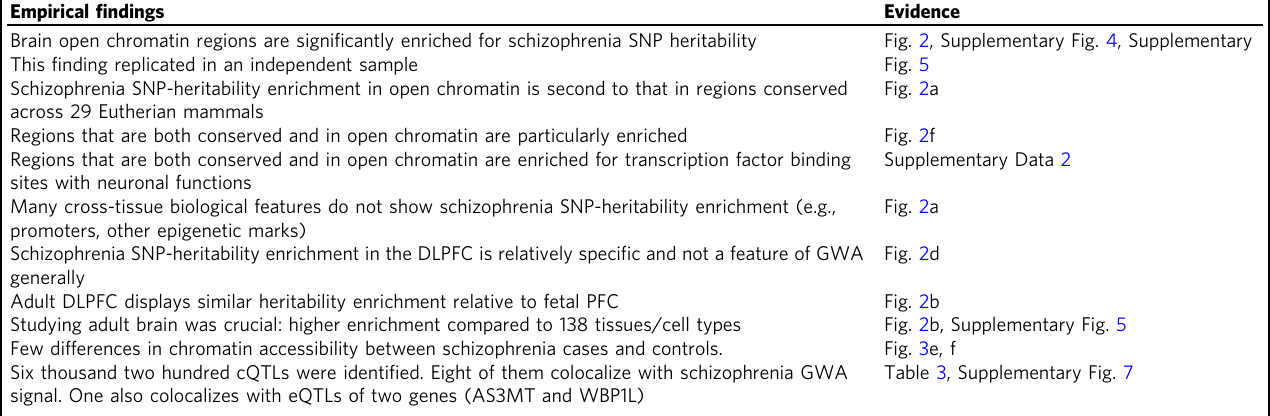
Fig. 2, Supplementary Fig. 4, Supplementary Fig. 5This fi nding replicated in an independent sample Fig. 2f